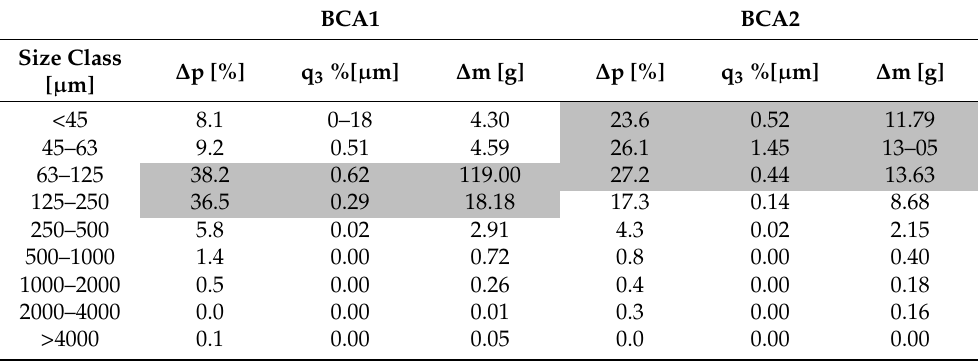
Table 2. Ash sieve analysis BCA1 and BCA2.